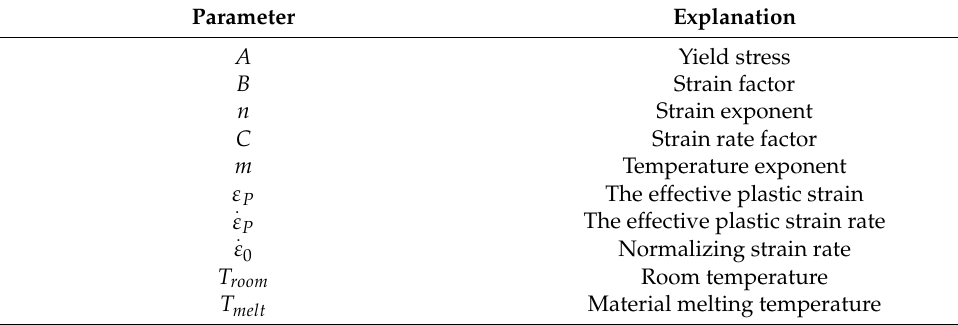
Table 1. The properties and the parameters of the Johnson–Cook material law. Parameter